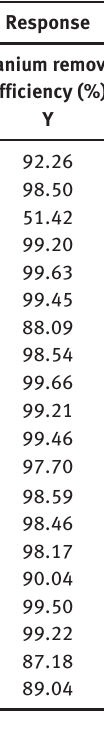
Table 1: Uranium removal experimental design used in RSM studies by using process variables showing observed values of uranium removal